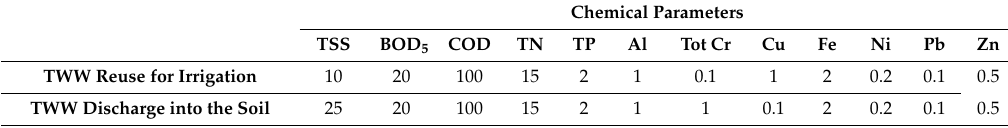
Table 4. Threshold values for Italian Legislative Decree no. 152 / 2006 concerning the chemical (mg L − 1 ) and microbiological (CFU 100 mL − 1 ) parameters of treated wastewater (TWW) for reuse in agricultural irrigation and discharge into